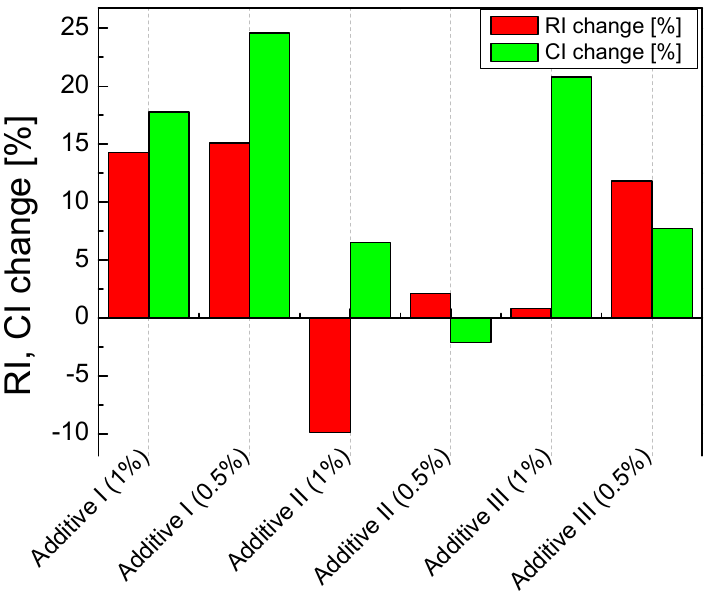
Figure 6. Changes in the RI and CI coefficient depend on the type and amount of the additive.